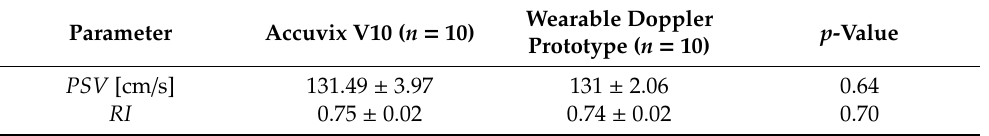
Table 1. The measured peak systolic velocity ( PSV ) and resistive index ( RI ) values (mean ± std) from the commercial rack-based Accuvix V10 machine and the developed wireless carotid wearable ultrasound Doppler system